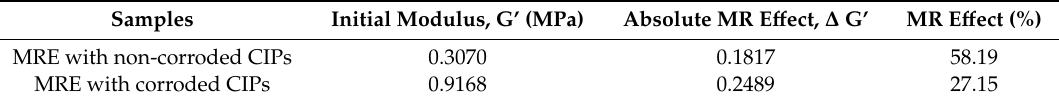
Table 5. Initial modulus, absolute and MR effect of MRE samples with corroded and non-corroded CIPs.